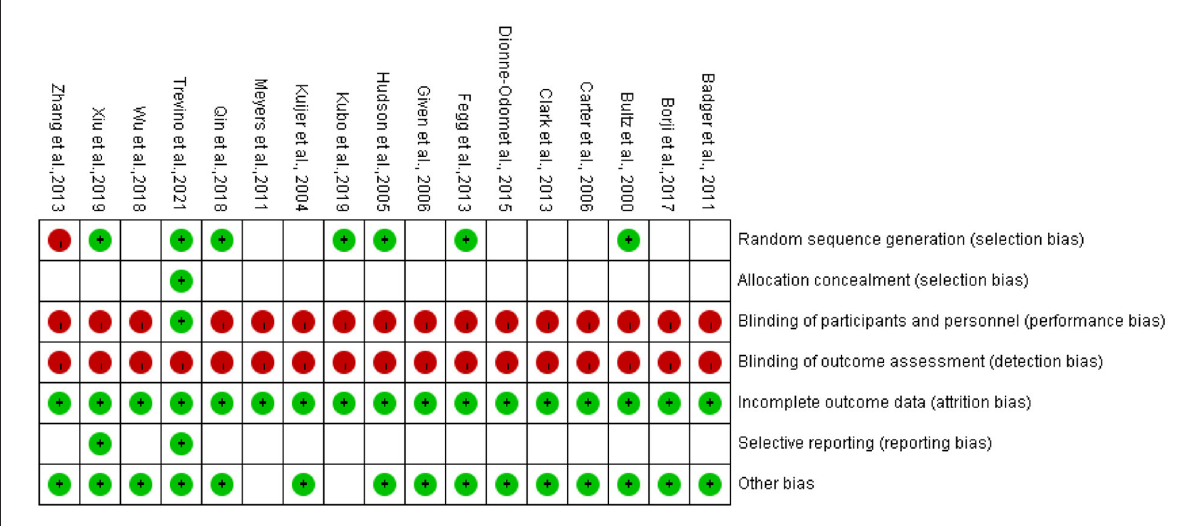
FIGURE3 Forest maps for subgroup analysis of effects on QOL.